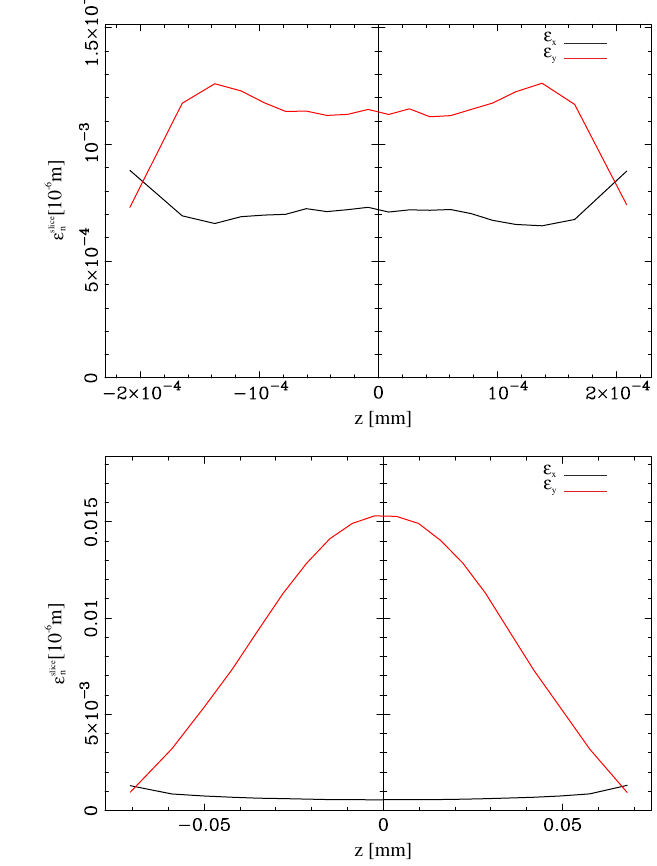
FIG. 5 (color online). Comparison of the slice emittance at 50 MeV (top) and at 5 MeV (bottom) for structure